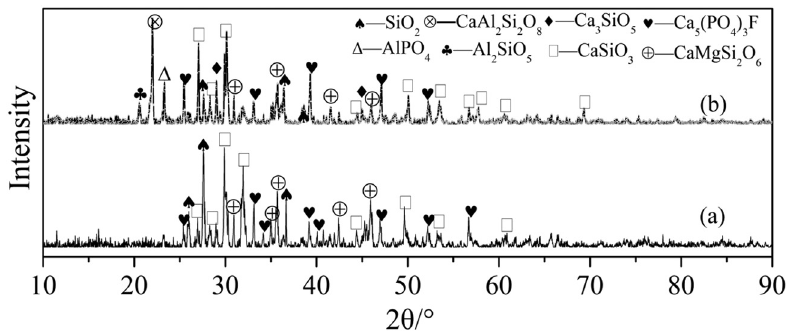
Figure 10: XRD images of SiO 2 system slag ( a ) and fl y ash system slag ( b ) at 1.300°C.